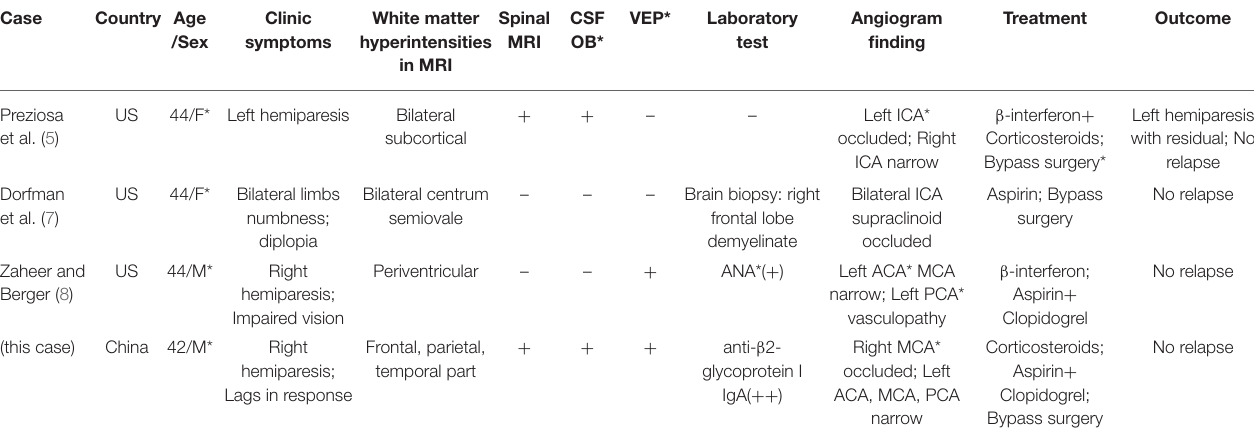
TABLE 1 | Neurological presentation and imaging findings of patients presented with MS and MM